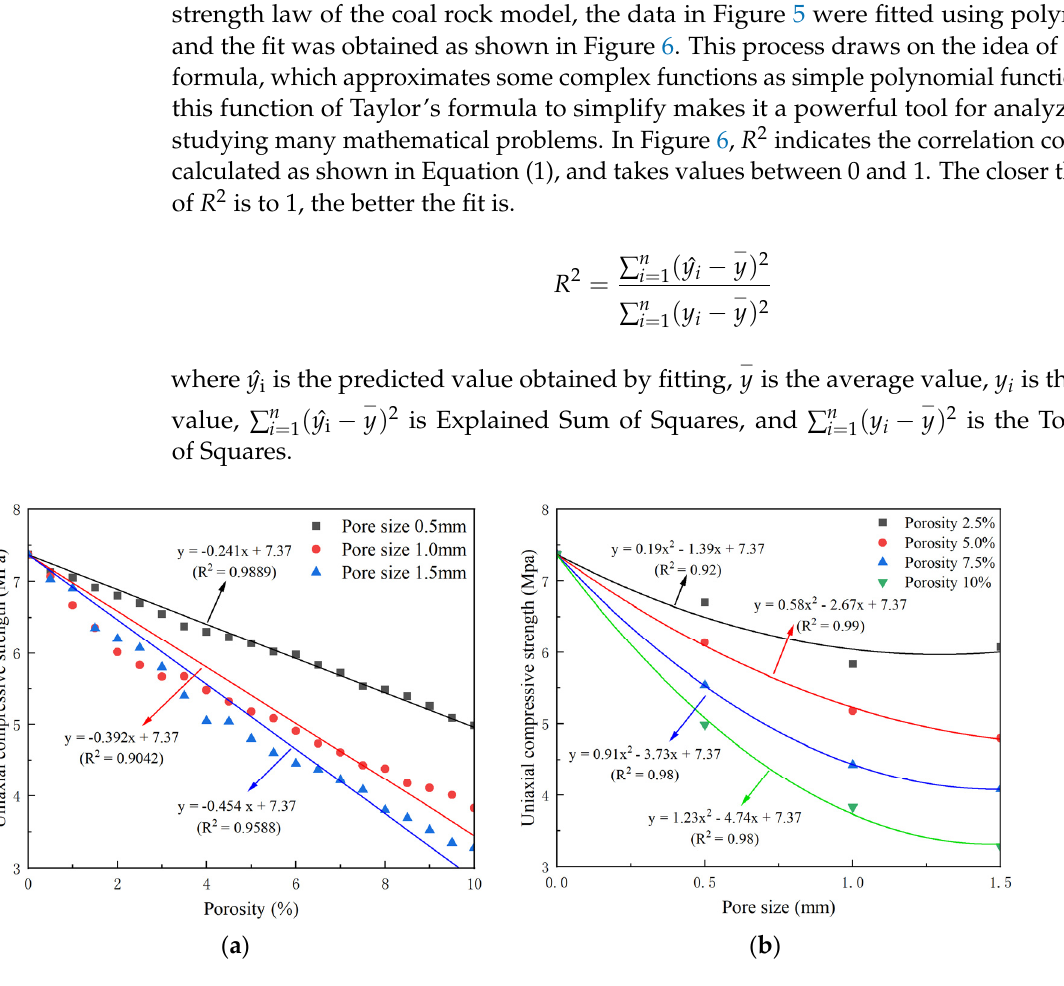
Figure 6. Fitted curve of compressive strength vs. pore size for coal rock model. ( a ) Uniaxial com- pressive strength-porosity fitting curve. ( b ) Uniaxial compressive strength-porosity fitting